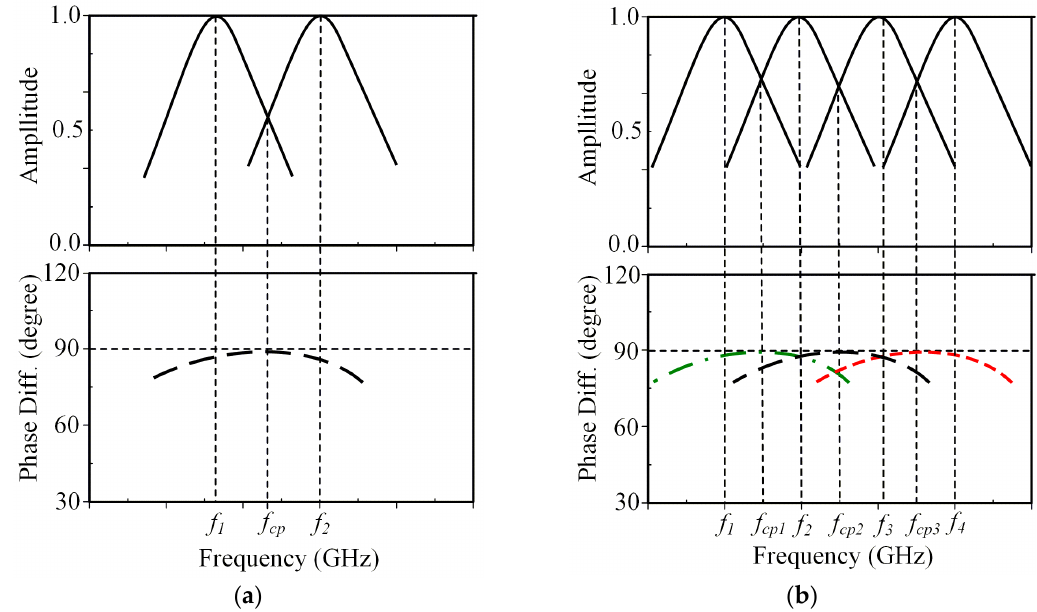
Figure 1. Characteristics of CP excitation: ( a ) single CP mode; ( b ) multi-CP modes.